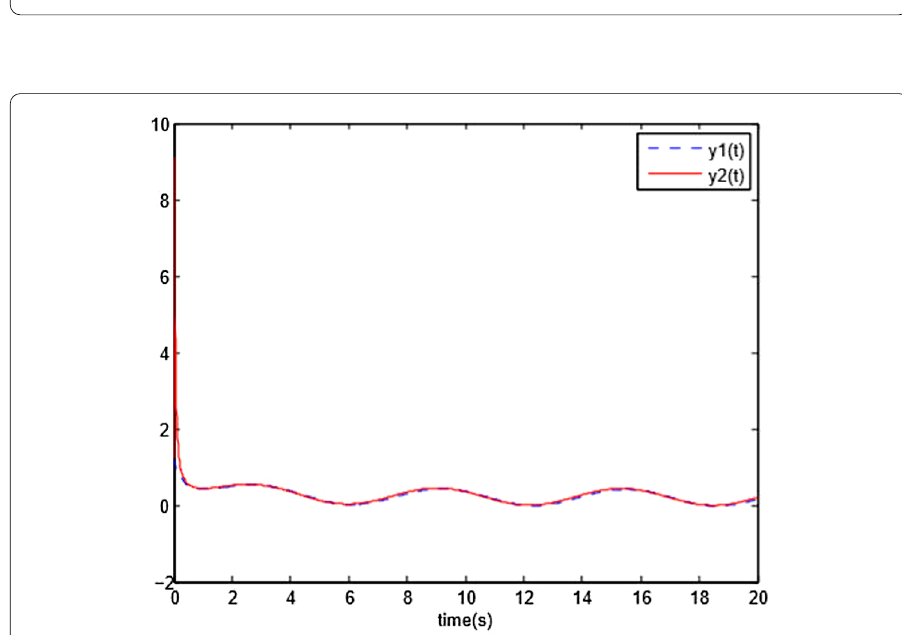
Figure 1 Dynamics of states u 1 ( t ) and v 1 ( t )